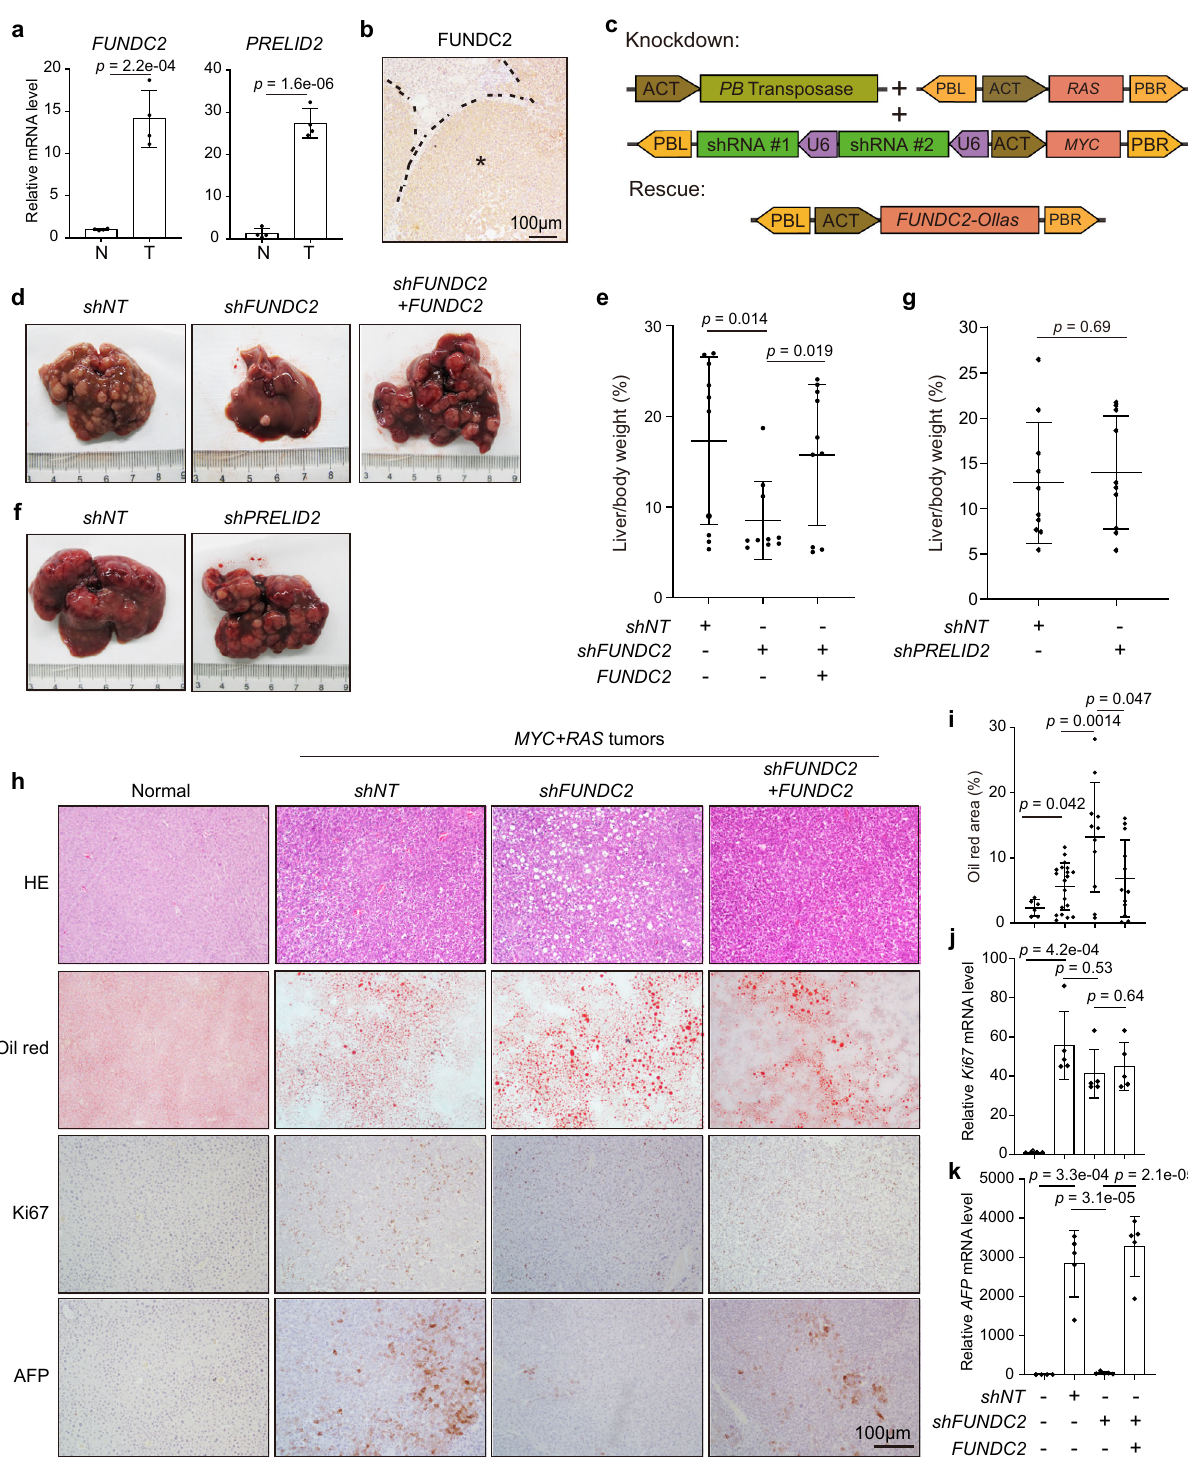
Fig. 2 Knockdown of FUNDC2 suppresses liver tumorigenesis. a mRNA levels of FUNDC2 and PRELID2 were induced in MYC + RAS mouse liver tumors as quanti fi ed by RT-PCR, n = 4. b Aberrant expression of FUNDC2 protein in mouse liver tumors by IHC staining. This experiment was repeated fi ve times. Tumor was indicated by asterisk. c Illustration of plasmids used for multiplexed genome editing in vivo. d , e Knockdown of FUNDC2 suppressed tumorigenesis induced by MYC + RAS . Representative livers at 80 days after injection were shown ( d ). Liver/body weight ratios were quanti fi ed in e , n = 10. f , g Knockdown of PRELID2 could not inhibit tumorigenesis induced by MYC + RAS . Experiments were similar to ( d , e ). h Impact of FUNDC2 knockdown on histopathological features. Liver sections were stained by HE, oil red, and IHC. i Quanti fi cation of oil red staining from 5 sections for each group in h . j , k Determination of Ki67 and AFP mRNA levels by quantitative RT-PCR, n = 5. n was biological replicates for all experiments. Data are presented as mean ± SD. p values were calculated by two-tailed unpaired Student ’ s t -test. Source data are provided as a Source data fi